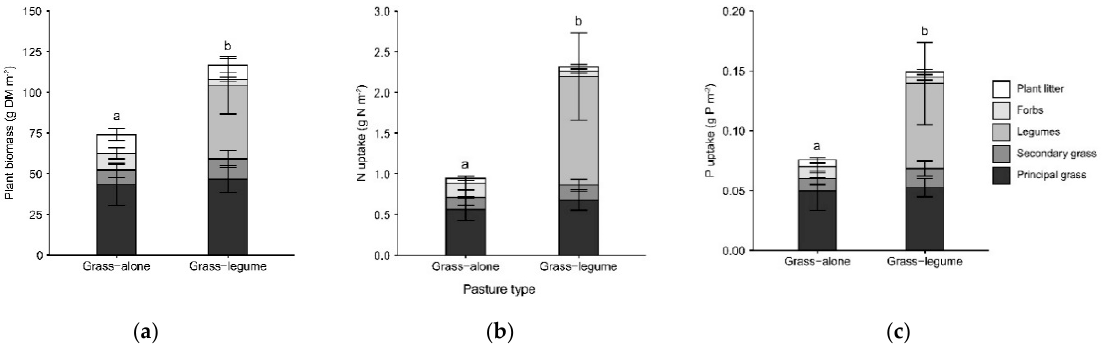
Figure 1. ( a ) Shoot plant biomass production ( b ) N uptake and ( c ) P uptake in grass alone and grass- legume pastures for each plant fraction; n = 10 for grass alone and 8 for grass-legume pastures. DM = dry matter. Different letters denote statistical differences for the total plant biomass production, N and P uptake of the sward per pasture type ( α = 0.05).